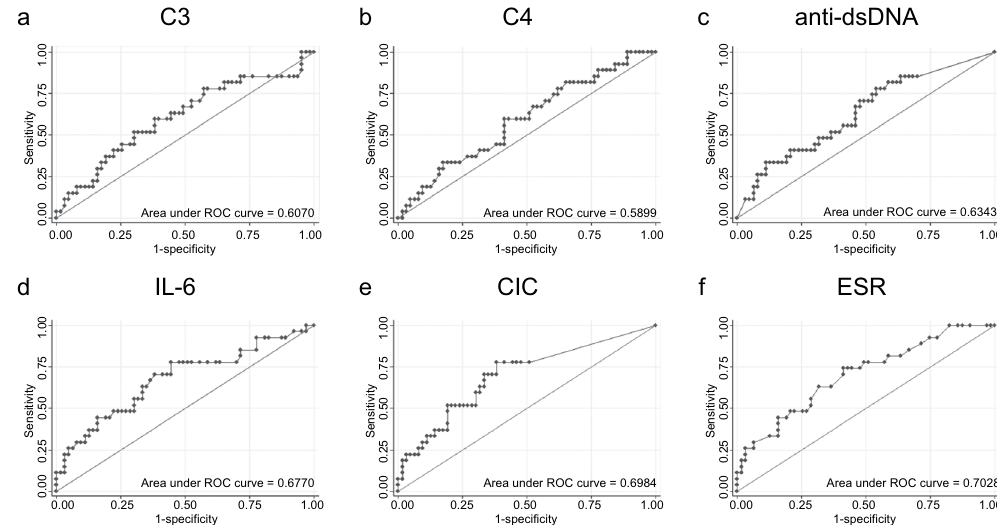
Figure 1. Receiver operating characteristic (ROC) curve and area under ROC curve of the following biomarkers; ( a ) Complement 3 (C3); ( b ) Complement 4 (C4); ( c ) anti-dsDNA; ( d ) Interleukin-6 (IL-6); ( e ) Circulating immune complex (CIC); ( f ) Erythrocyte sedimentation rate (ESR).